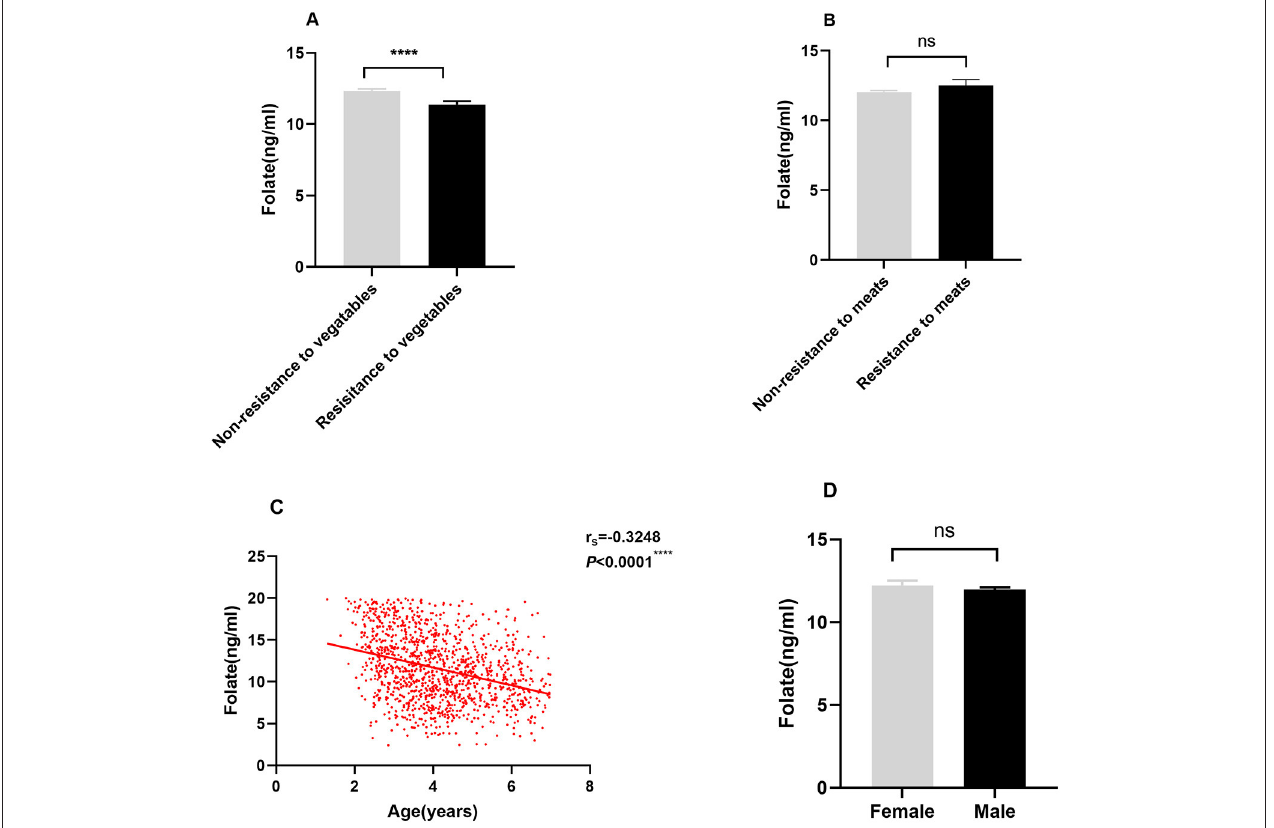
FIGURE 2 | Associations of mealtime behaviors, age, and gender with serum folate level in autistic children. (A,B) Effect of mealtime behaviors on folate levels in ASD children; (C) : Correlation of folate levels with age; (D) : Comparison of folate levels between male and female children with ASD. Data was presented as Mean ± SEM, the Mann-Whitney test was used for the comparison. **** P < 0.0001, “ns” no significant